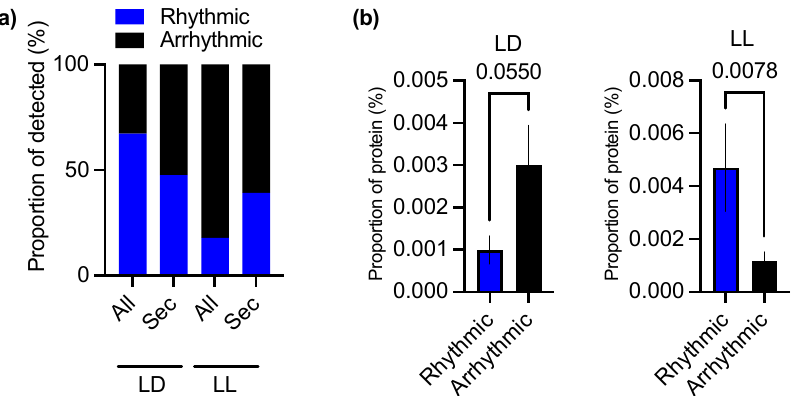
Figure 2. Rhythmicity of the selenoproteome: ( a ) Proportion of rhythmic versus arrhythmic proteins under LD or LL in the overall dataset reported in [23], or those proteins containing a selenocysteine (Sec). ( b ) Amino acid usage for selenocysteine, expressed as the average proportion of a protein amongst rhythmic or arrhythmic proteins under LD (left) or LL (right) conditions. Statistics are unpaired nonparametric tests (Mann–Whitney). Table 1. The Ostreococcus selenoproteins and rhythmicity parameters under light/dark cycles (LD) or constant light (LL): Provided are the p -value for rhythmicity, phase (in hours; h), relative ampli- tude (Rel. Amp., in percentage), and mean abundance (Mean Ab., in arbitrary units; a.u.) of the selenoproteins, as detected in our previous proteomics study [23]. ND = not done, meaning the anal- ysis was not possible due to too many missing values in the dataset.